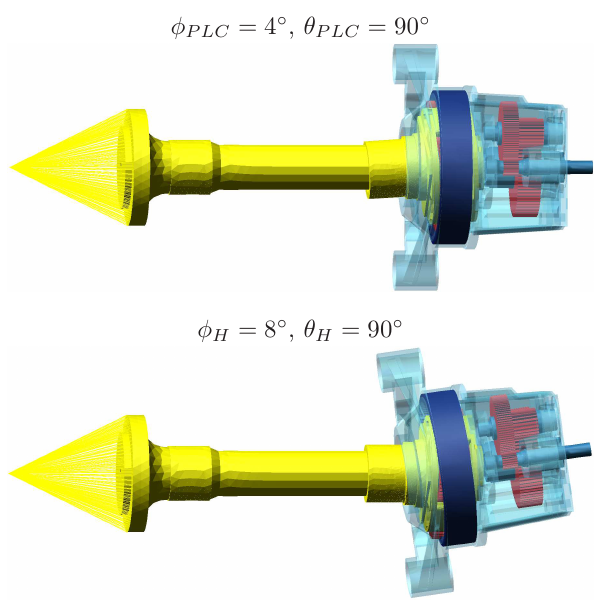
Figure 4: Illustration of the PLC and housing misalign- ment.